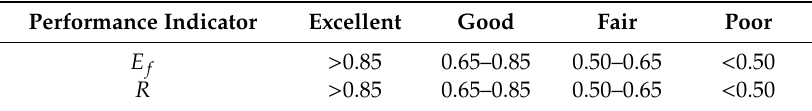
Table 1. Performance criteria for the model